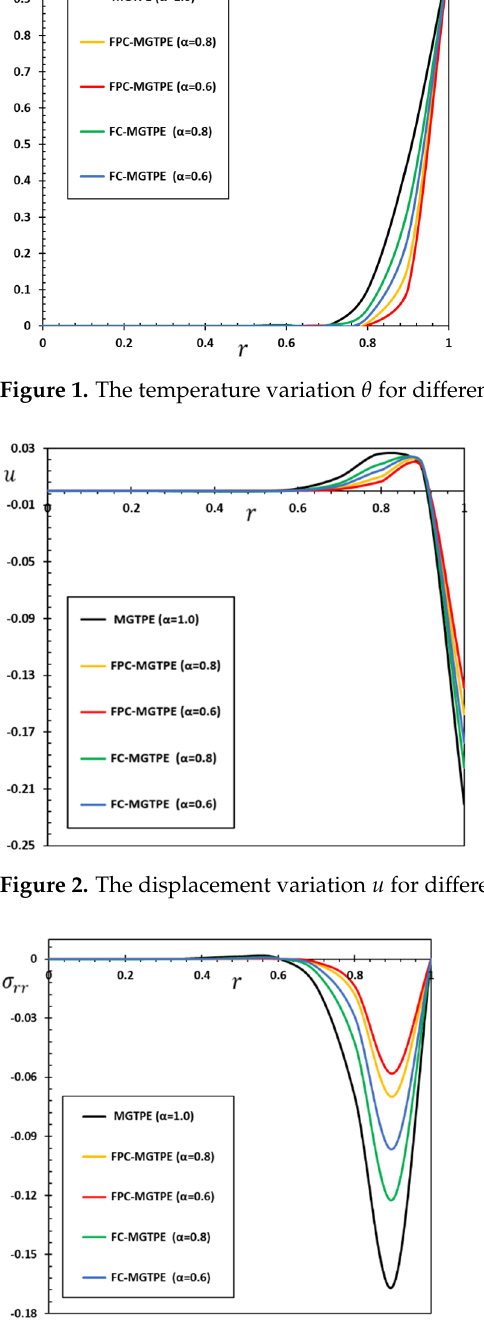
Figure 3. The radial stress variation σ rr for different fractional derivatives.